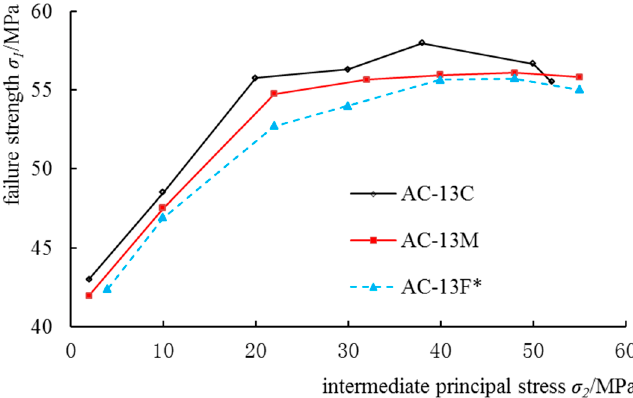
Figure 4. AC-13 triaxial compressive strength changing with intermediate principal stress.